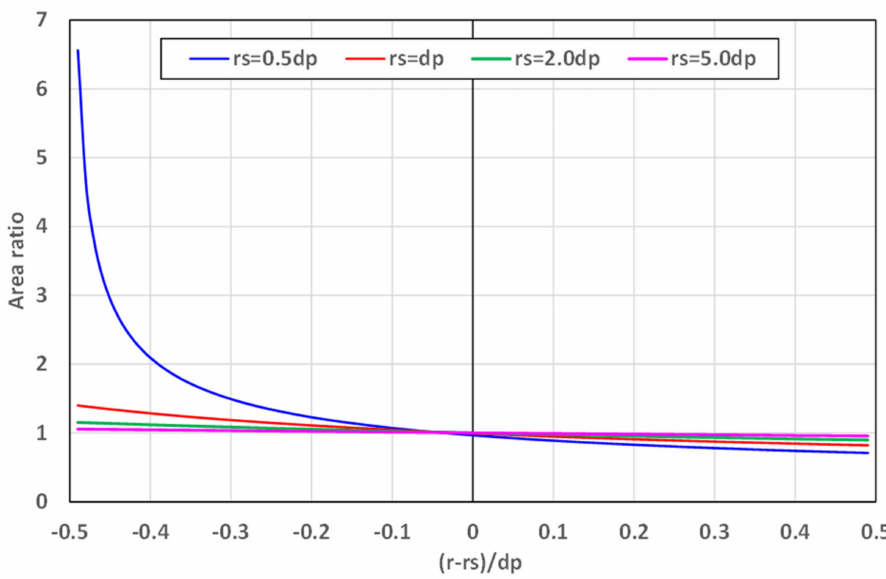
Figure 4. Results of the analysis of asymptotic behavior of Equation (17) for r p ≤ r s ≤ 30 r p